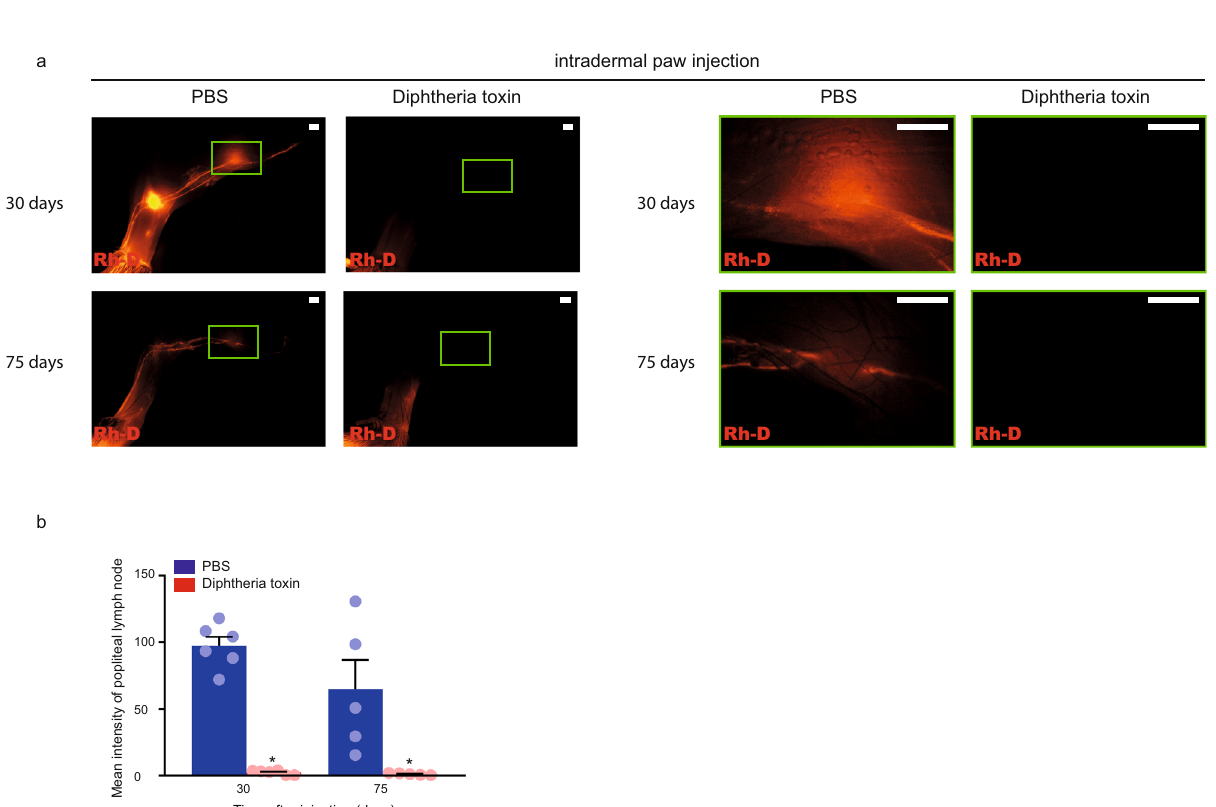
Fig. 8 Administration of Diphtheria toxin into the paws of tamoxifen-treated Flt4-CreER T2 ; iDTR fl / fl animals reduces lymphatic function as the result of secondary lymphedema development. a Monitoring active lymphatic function in the contralateral hind limbs of the same tamoxifen-treated Flt4- CreER T2 ; iDTR fl / fl mouse 30 or 75 days after intradermal injection of PBS into one paw and Diphtheria toxin into another paw. 70 kDa Rh-D was injected into the paws and the transport of the molecule was monitored by fl uorescent microscopy 90 min post Rh-D administration. Representative images are shown of 5 – 6 mouse hind limbs in each group. (bars, 1000 µ m). Green rectangles show the magni fi ed area which represent the area of popliteal lymph nodes. b Fluorescent intensity of popliteal lymph node of tamoxifen-treated Flt4-CreER T2 ; iDTR fl / fl mice 30 and 75 days after intradermal paw injection with PBS or Diphtheria toxin. 70 kDa Rh-D was injected into the paws and the transport of the molecule was monitored by fl uorescent microscopy 90 min post Rh-D administration. Quantitative data are represented as mean and SEM in 5 – 6 popliteal lymph nodes in each group (two-tailed, paired T -test, P = 4.51 × 10 − 5 after 30 days for 6 mice and P = 0.0421 after 75 days for 5 mice). Asterisks indicate P < 0.05 compared with